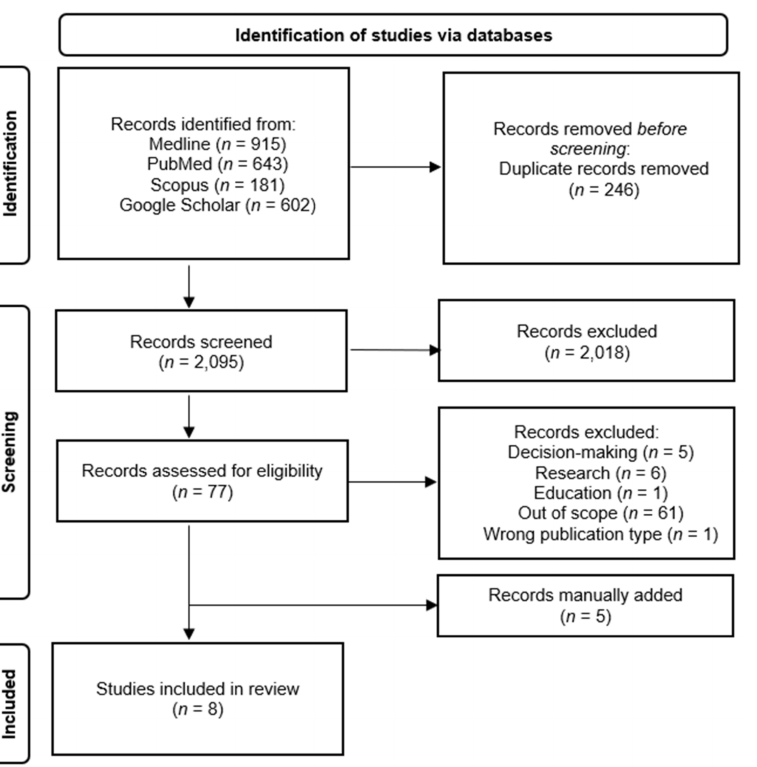
Figure 1. PRISMA Diagram. From: Page MJ, McKenzie JE, Bossuyt PM, Boutron I, Hoffmann